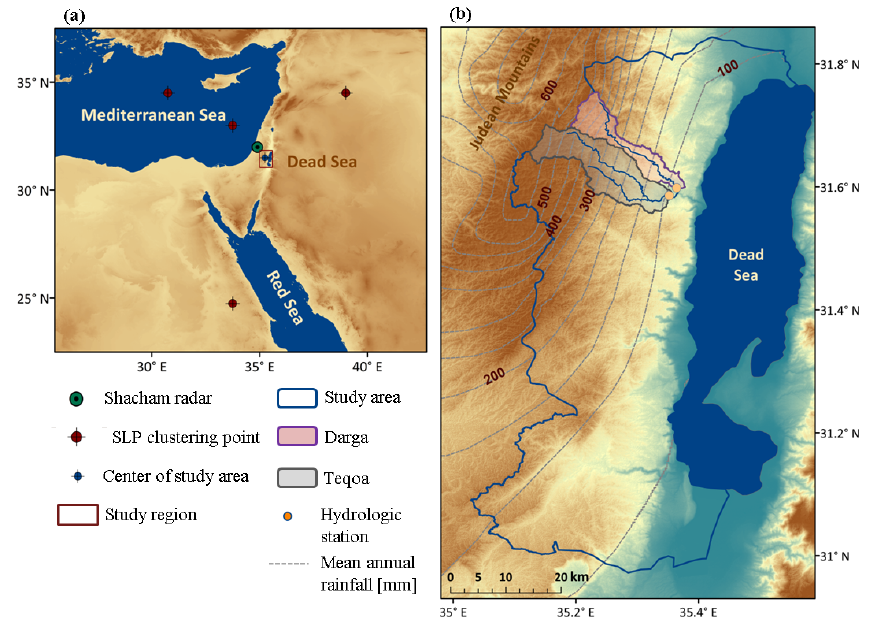
Figure 1. Map of the Eastern Mediterranean area presenting radar location and coordinates used to derive sea level pressure (SLP) differences for synoptic classification (a) . A map of the study area with the Darga and Teqoa catchments (b) . Isohyets over the study region represent long-term (30 years, 1980–2010) mean annual rainfall